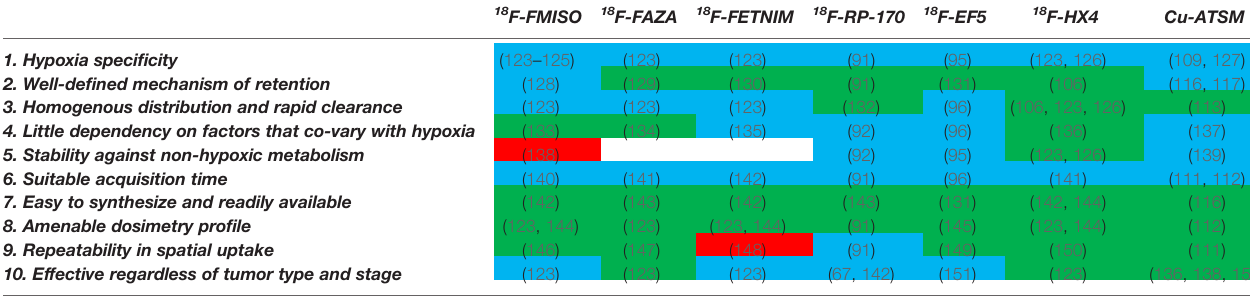
TABLE 2 | Comparison of 18 F-labeled nitroimidazoles and Cu-labeled diacetyl-bis(N4-methylthiosemicarbazone) highlighting the characteristics of the ideal hypoxia PET